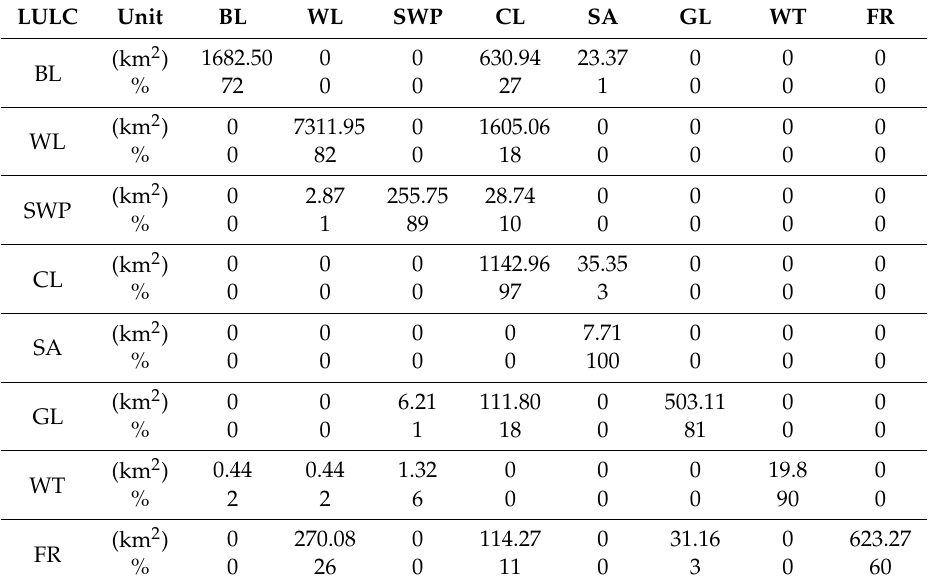
Table 10. Transition matrix showing LULC change in Wami Sub-catchment between 2000–2016.